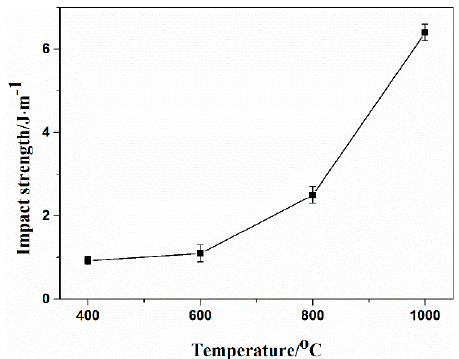
Figure 13. Impact strength of the sintered specimens sintered at various temperatures.